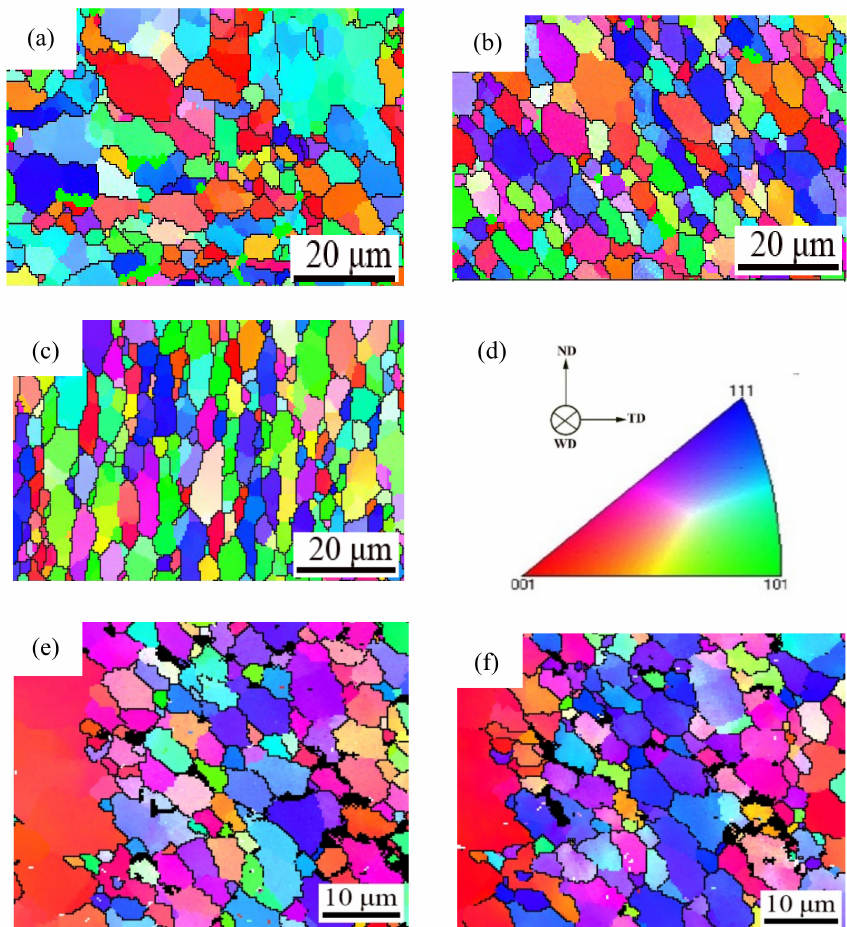
Figure 3. Grain orientation maps: ( a ) AS-HAZ; ( b ) SZ; ( c ) RS-TMAZ; ( d ) Orientation standard of 7A52 aluminum alloy FSW joint; ( e ) Yield of the RS; ( f ) Fracture of the